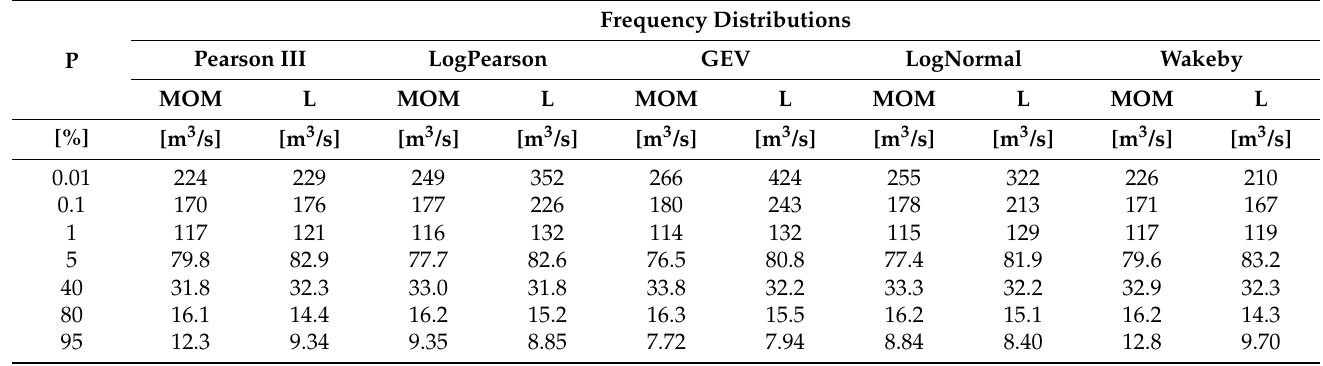
Table 6. Comparison of the estimated values for usual probability for the Prigor river.